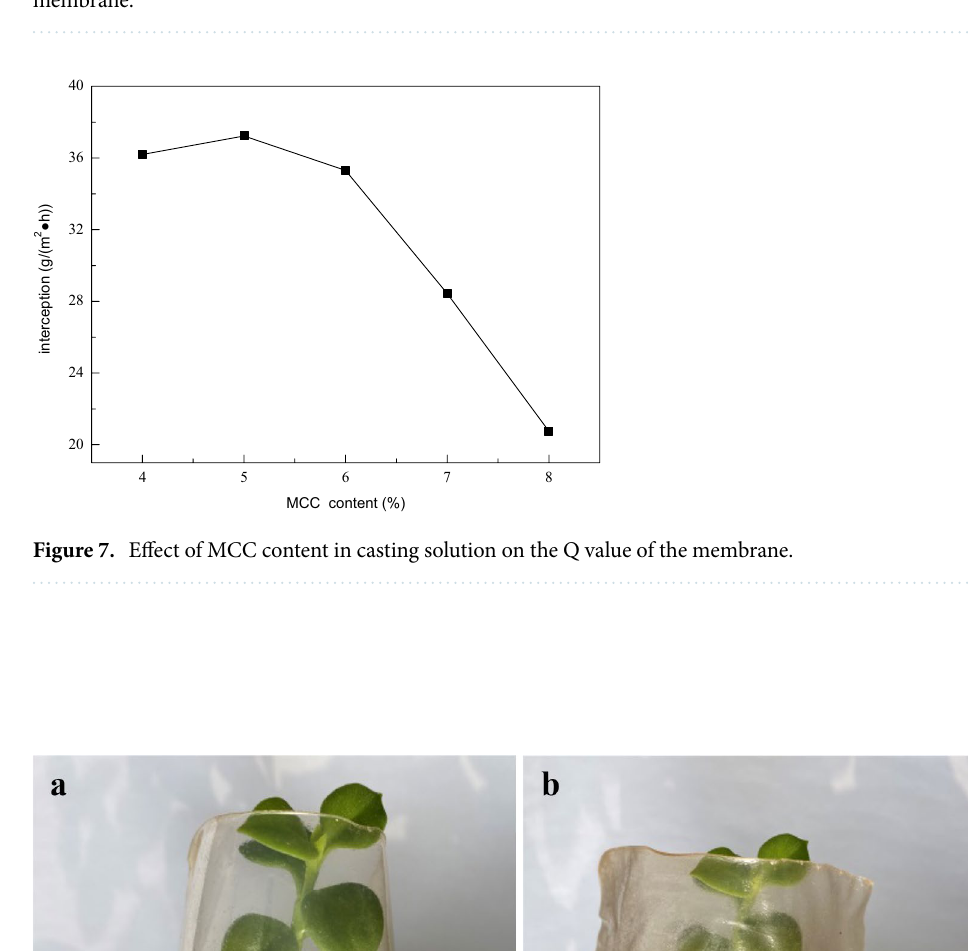
Figure 6. Effect of MCC content in casting solution on the water flux (J) and rejection rate (R) of the membrane.